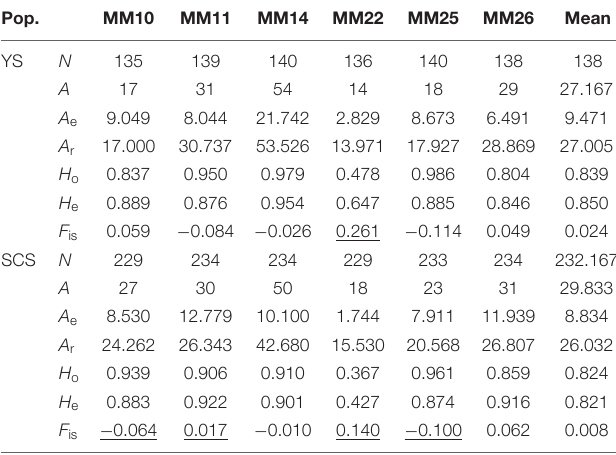
TABLE 3 | Allelic variability at six microsatellite loci in two genetic clusters of M. meretrix . Pop.